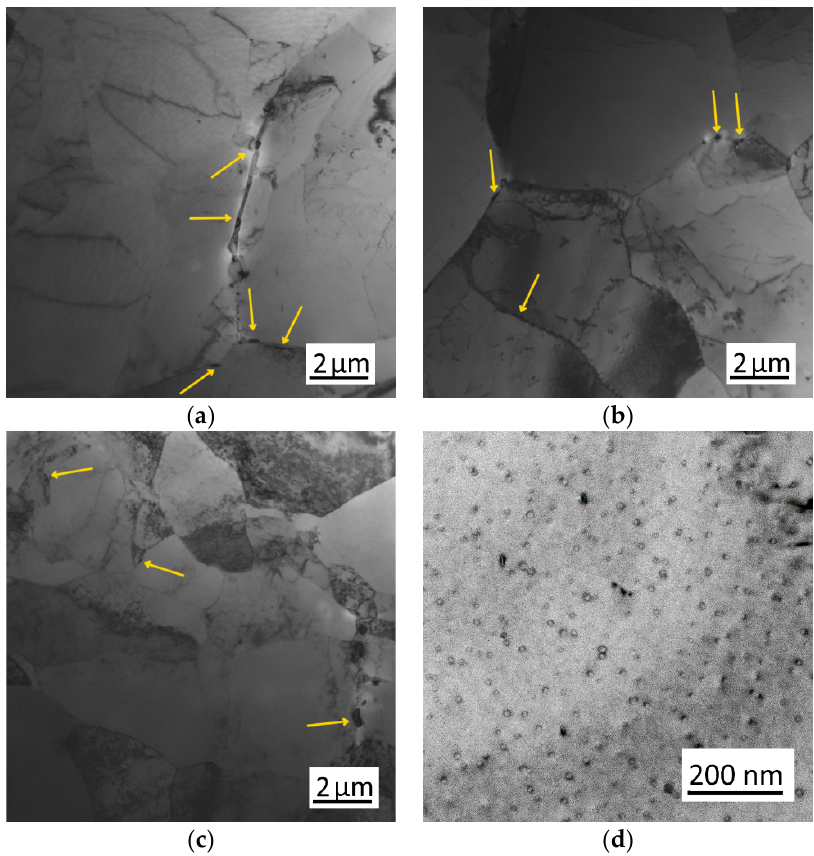
Figure 7. TEM bright field images of grain boundary particles after linear heating up to 500 °C and further artificial aging 500 °C/80 min in Al-Li-Cu-Mg-Zr alloy ( a , b ) and Al-Li-Cu-Mg-Zr-Sc alloy ( c ). Particles of Al 3 Sc 1-x Zr x phase in Al-Li-Cu-Mg-Zr-Sc alloy ( d ).